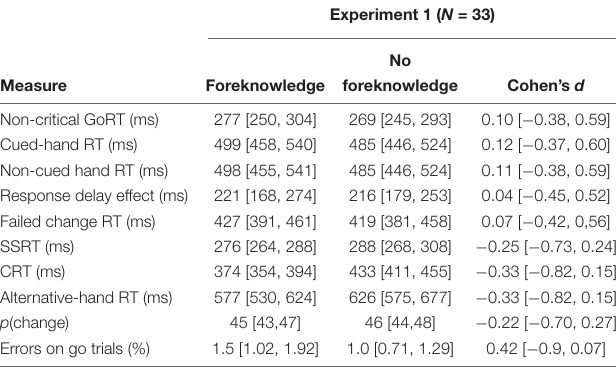
TABLE 2 | Means and 95% confidence intervals for Experiment 1 ( N =